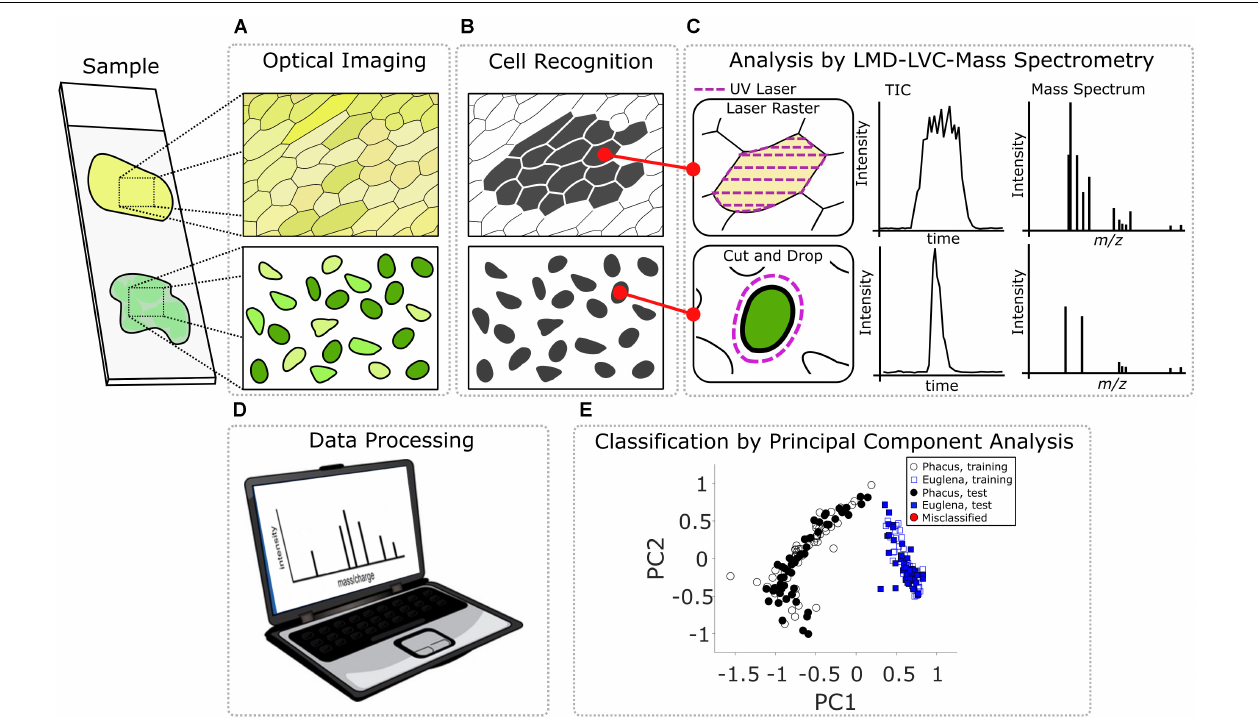
FIGURE 1 | Steps of the optically guided cell selection, sampling, and analysis technology: (A) acquisition of the optical image of the sample; (B) application of image analysis algorithm for image segmentation and cell recognition; (C) sampling of selected cell and mass spectrometric data acquisition; (D) processing of mass spectrometric dataset; and (E) classification of analyzed cells.